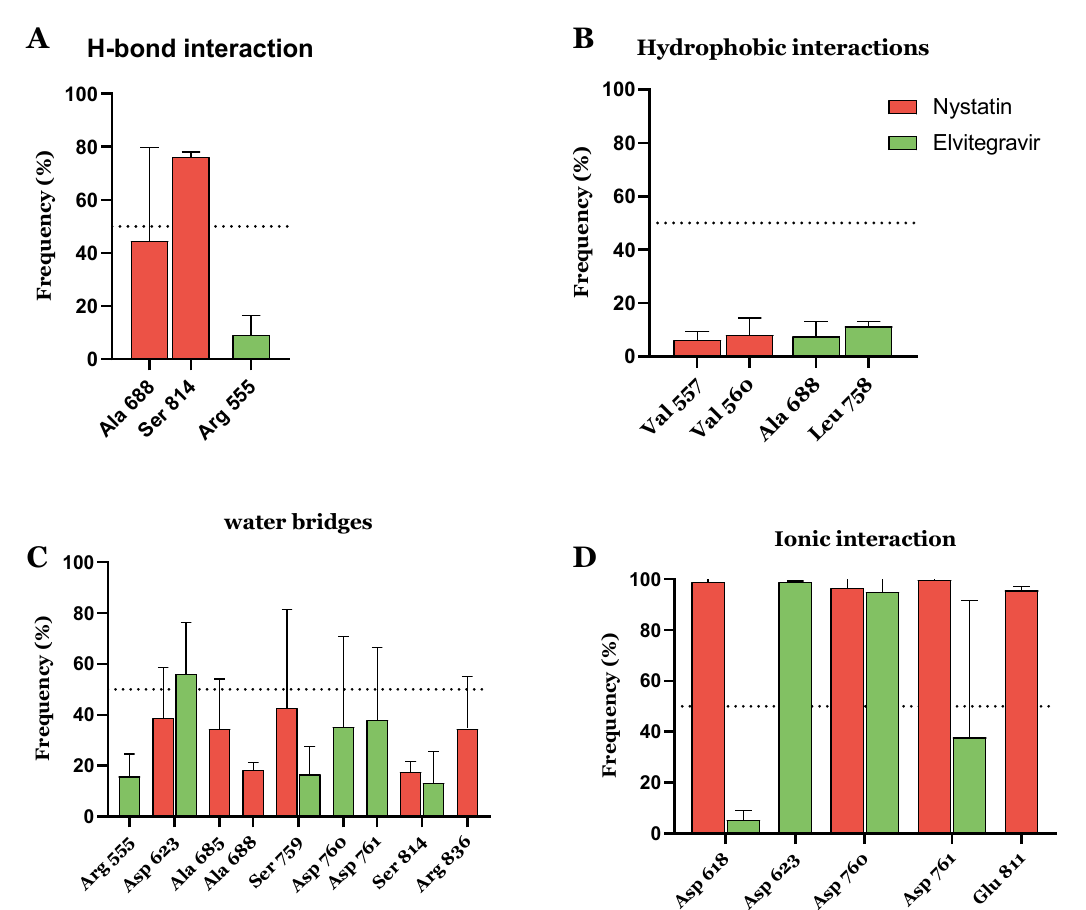
Figure 9. Nystatin and elvitegravir protein–ligand interaction along the 100 ns simulation. Frequency of hydrogen bonding interactions ( A ); hydrophobic interactions ( B ); water-mediated hydrogen bonding interactions ( C ); ionic interactions ( D ).